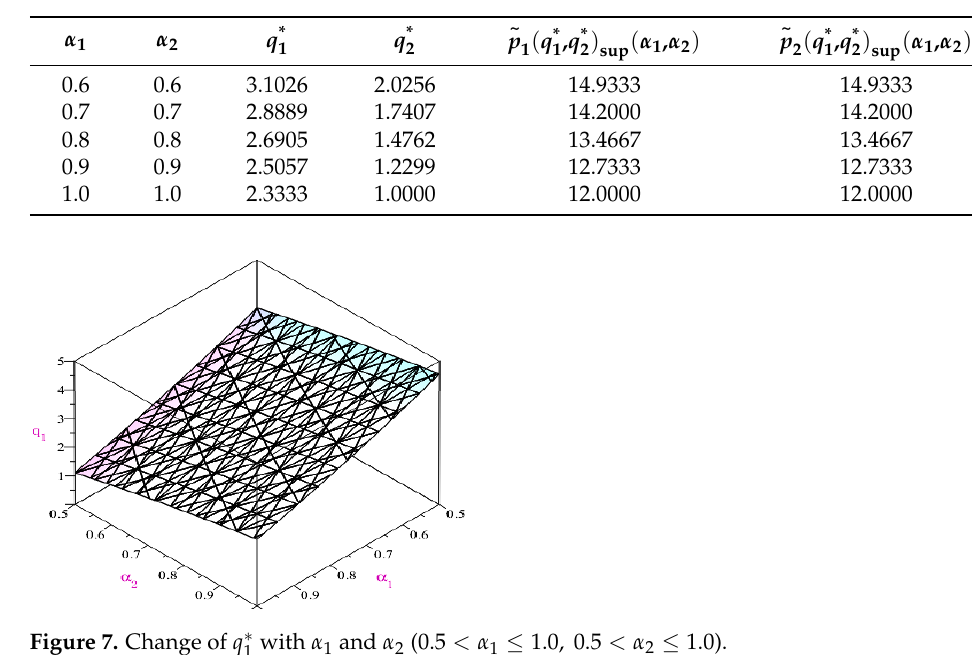
Table 13. ( α 1 , α 2 )-optimistic equilibrium quantity for Scenario IV when the risk aversion levels for CDT and AG increase.